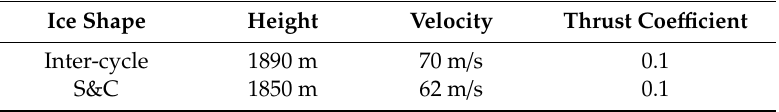
Table 5. Initial flight conditions of horizontal tail iced aircraft.